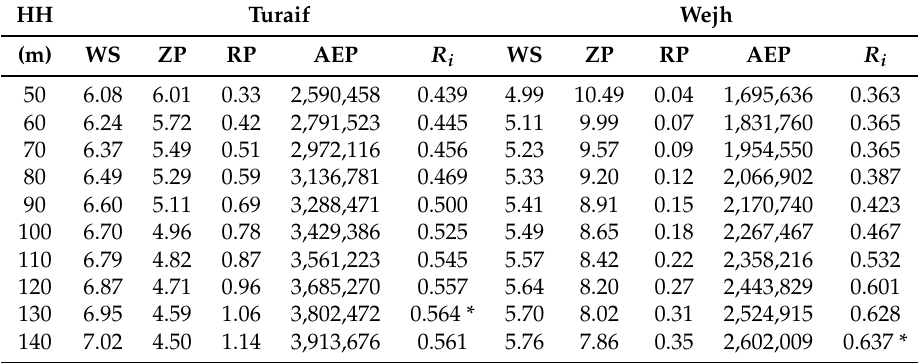
Table A10. TOPSIS analysis for turbine Leitwind LTW70-2000. The best choice for each site is marked with an asterisk.